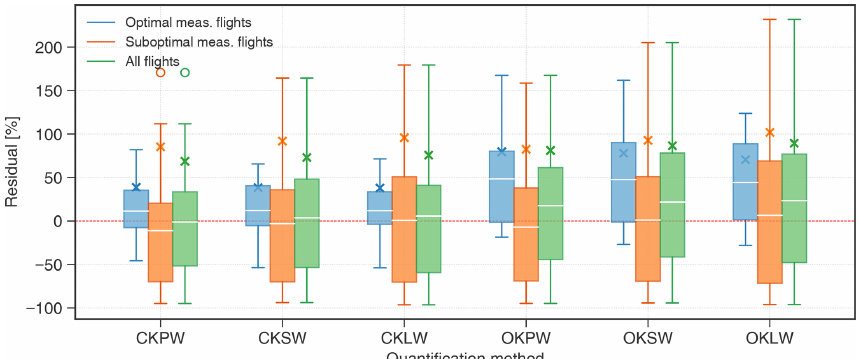
Figure 9. Colour-coded box plots represent the range of residuals in flux estimates of measurement flights grouped according to meteoro- logical and threshold conditions. Solid white lines represent the mean bias and the × marks represent the RMSE for each quantification approach. Definitions of optimal and suboptimal measurement flights are defined in Sect.